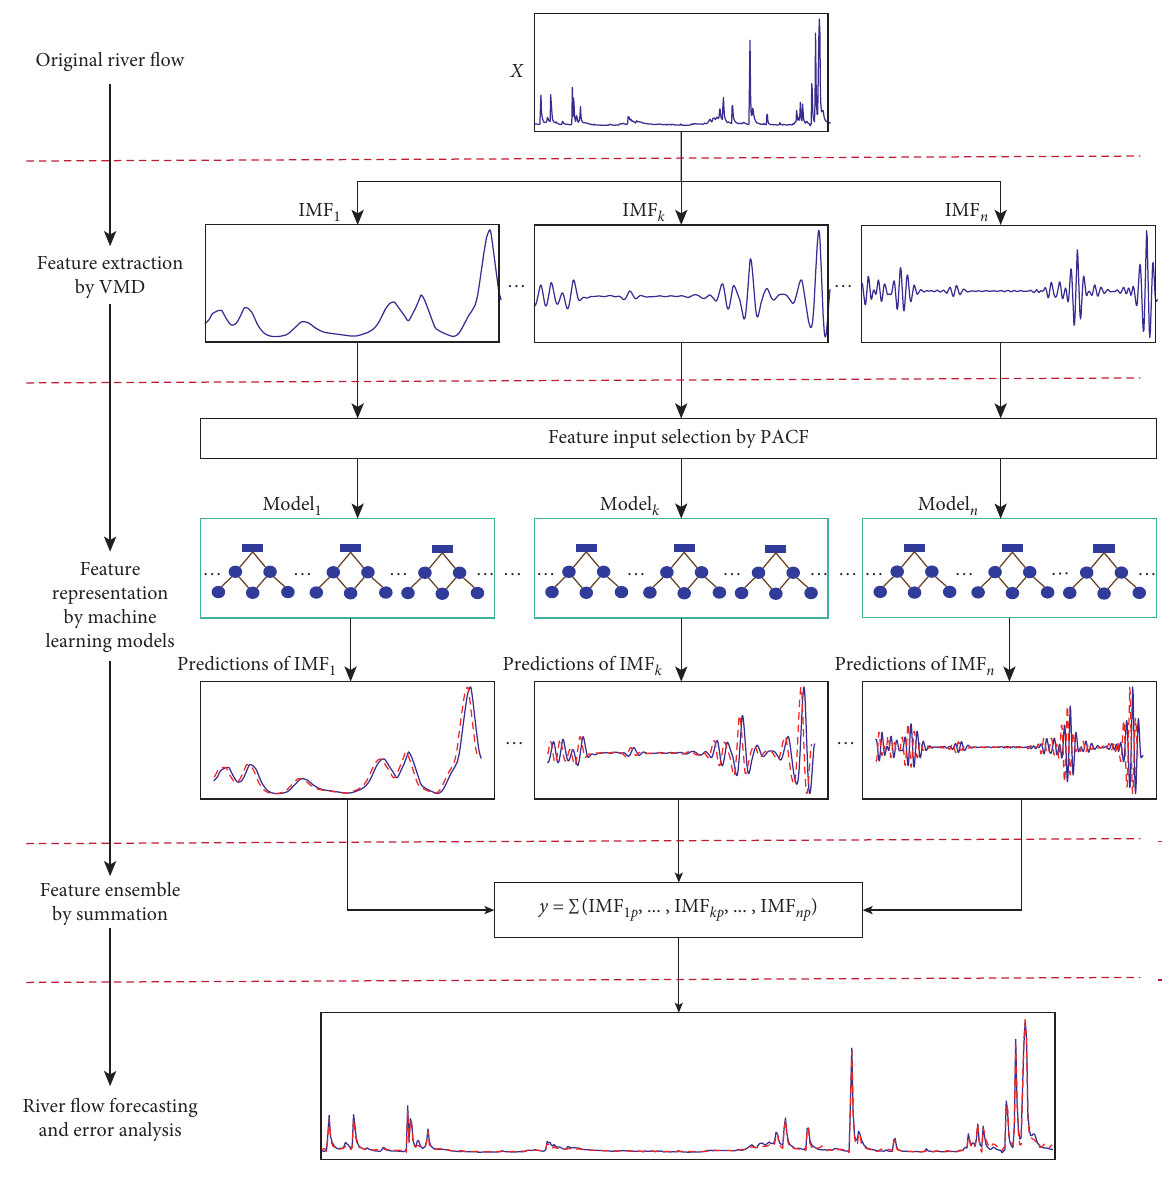
Figure 1: The technique of VMD-based multidimensional feature learning with hybrid